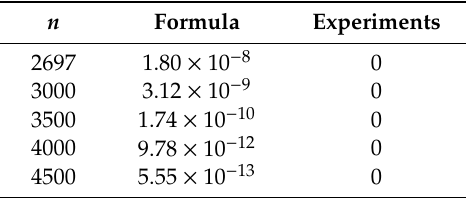
Table 7. Probability that the OOV algorithm will incorrectly estimate zero bit of the noise vector whose weight is incorrectly estimated as 77.